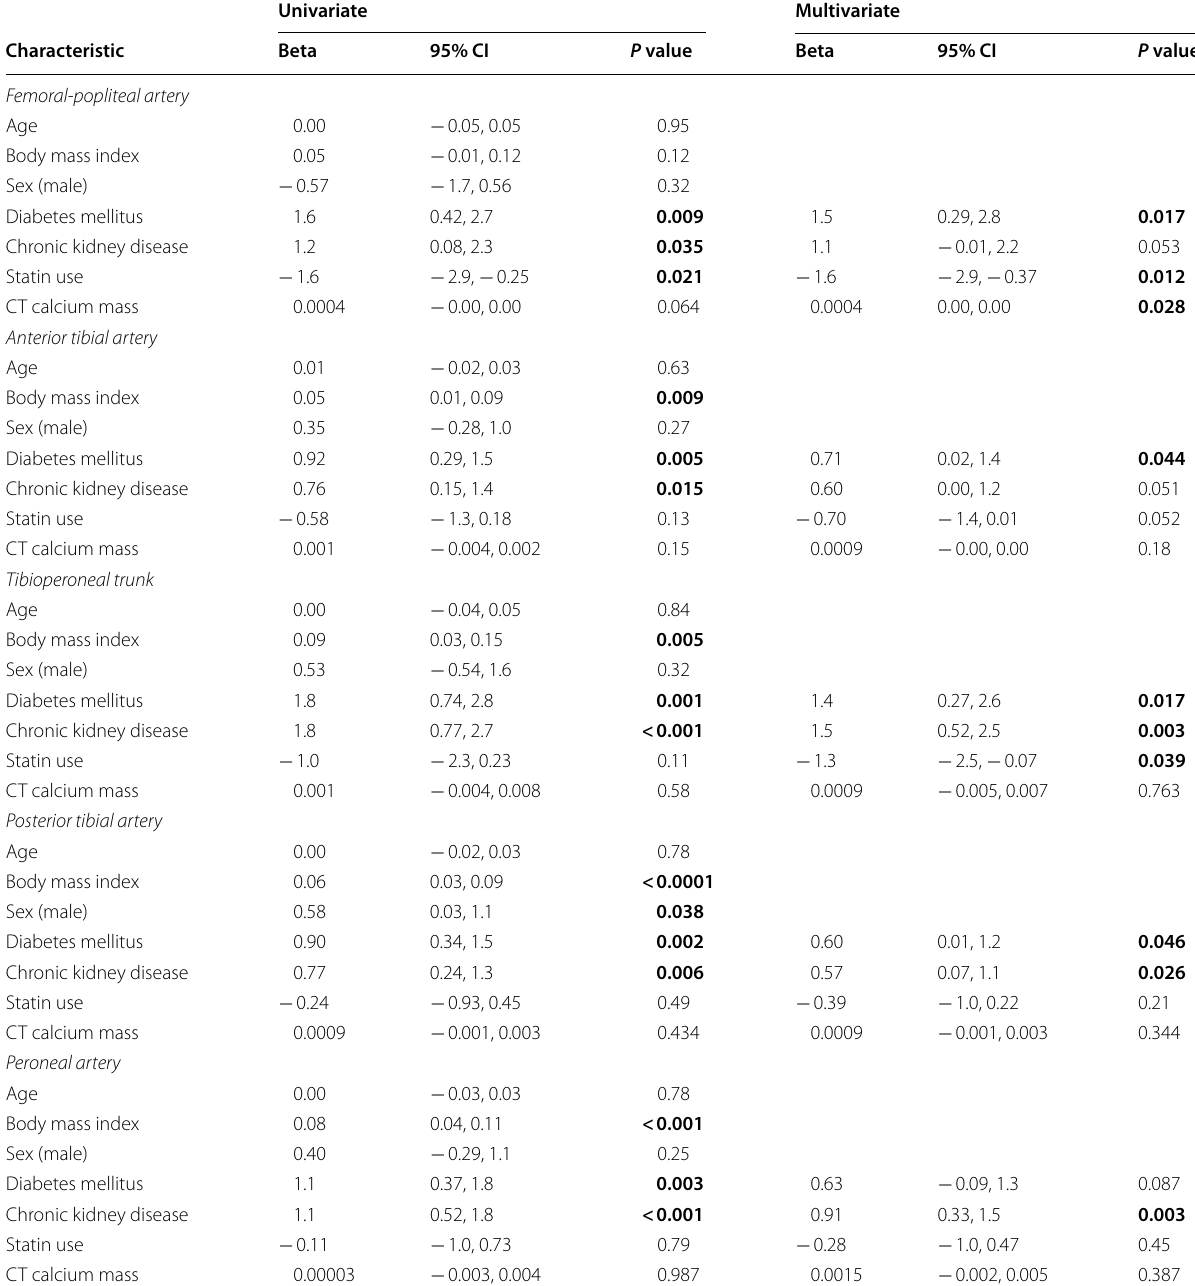
Table 2 Univariate and multivariate analyses of lower extremity